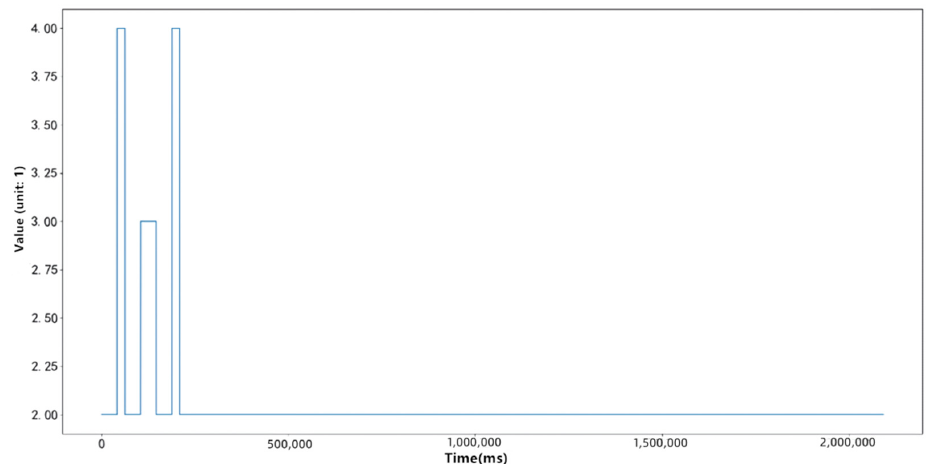
Figure 4. Time series after SAX dimensionality reduction compression.